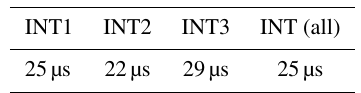
Figure 2. dUT1 estimation from different VLBI Intensive sessions w.r.t. IERS 14 C04 (2010–2018). Table 2. Comparison of the VLBI Intensive dUT1 estimates with IERS 14 C04 series: WRMS deviation of residuals.